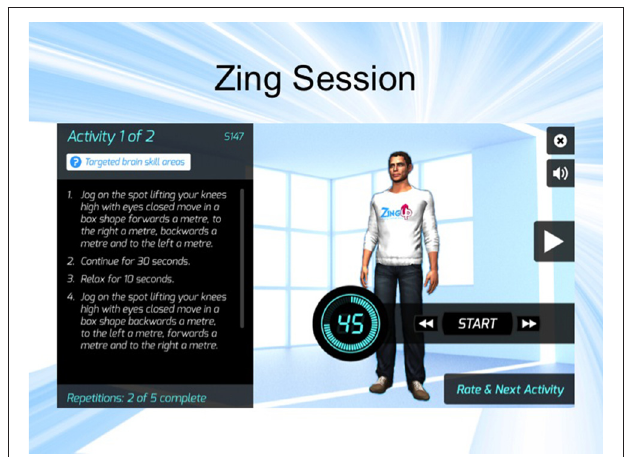
FIGURE 1 | Sample screen from the Zing intervention. This is an example of a screen from the focus strand, at a low level and aimed at developing dual tasking